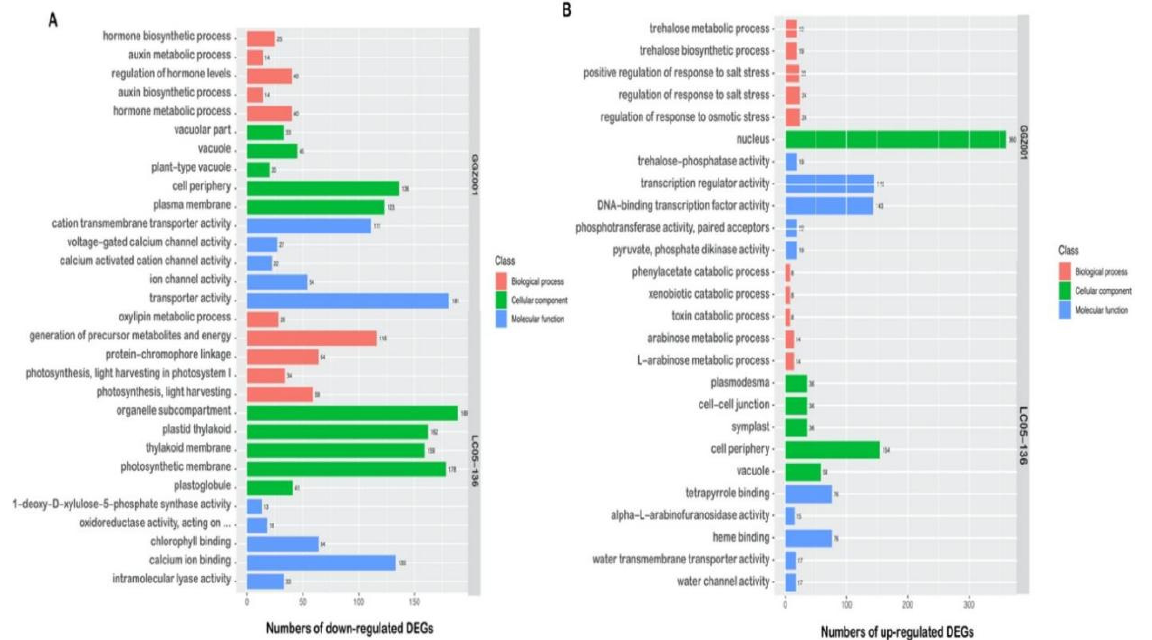
Figure 5. GO enrichment analysis of downregulated ( A ) and upregulated ( B ) DEGs in LC05 − 136 and GGZ001.